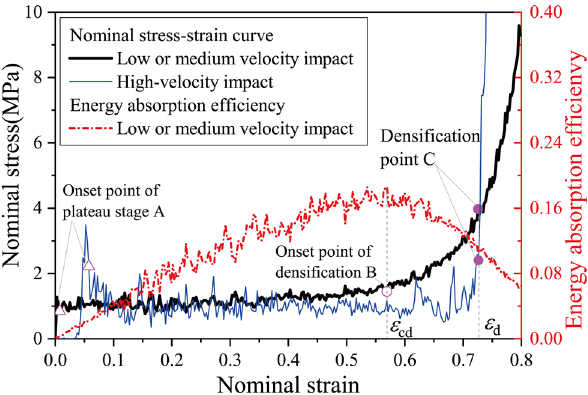
Figure 5: Characteristic strain points of the Voronoi under impact compression: A, B, and C represent the onset point of plateau stage, the onset point of densi fi cation stage, and the densi fi cation point,